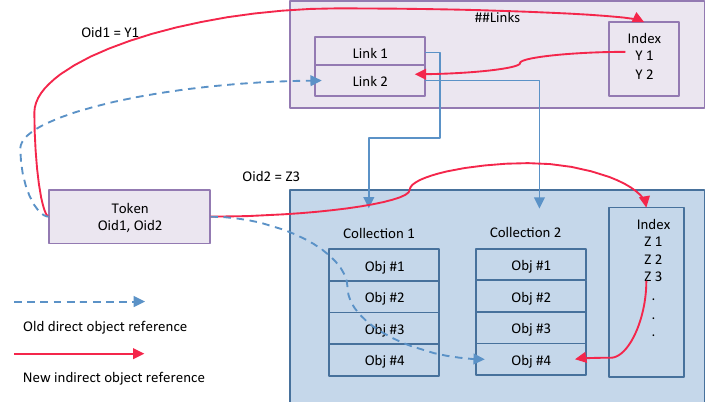
Figure 2. Indirect object access with indexing. An object reference (Token) is represented as a pair of identifiers (oid1, oid2). Oid1 points to an entry in the Links table describing containers, Oid2 enumerates an object in that